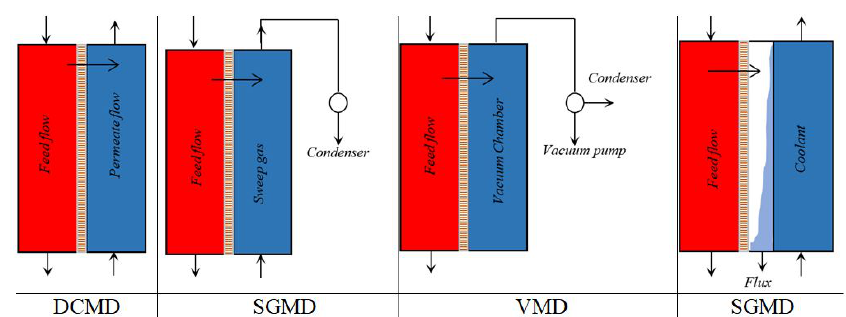
Figure 19. Membrane Distillation Desalination Processes.